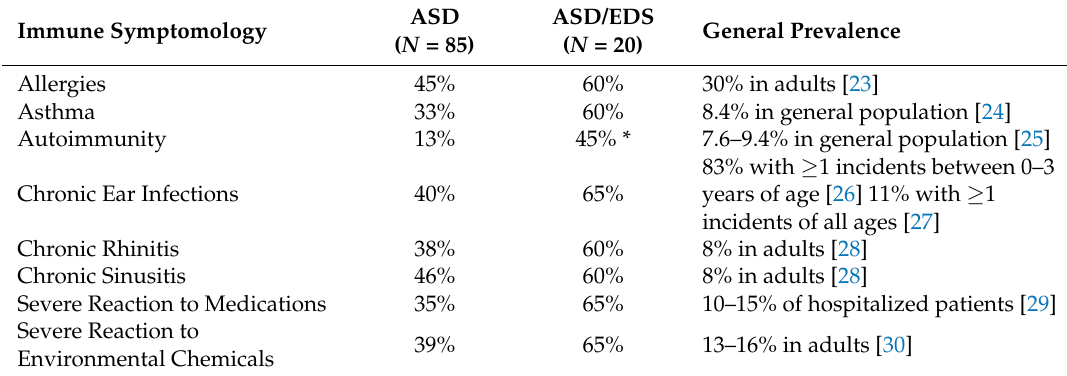
Table 2. Reported rates of various immune-related symptoms according to group, as well as estimated general prevalence rates.